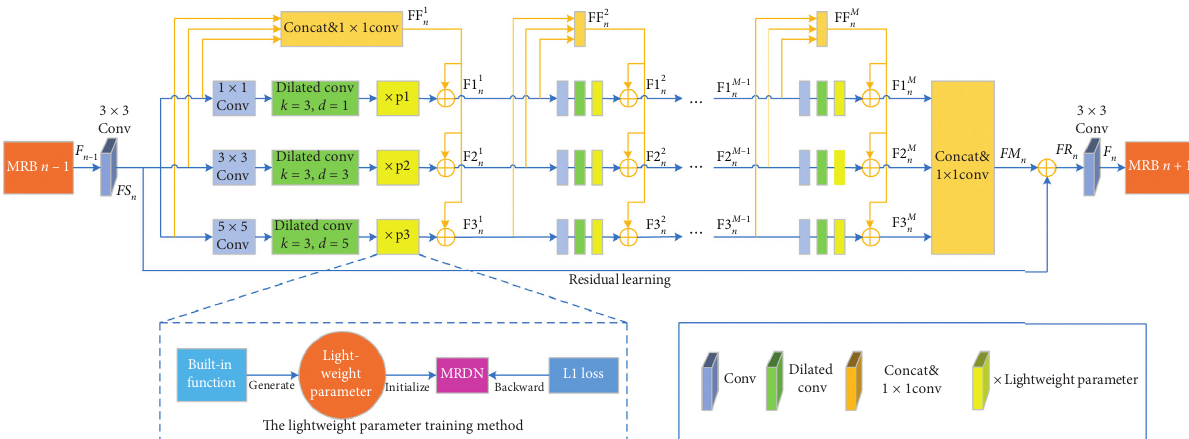
Figure 2: Structure of the multiscale residual